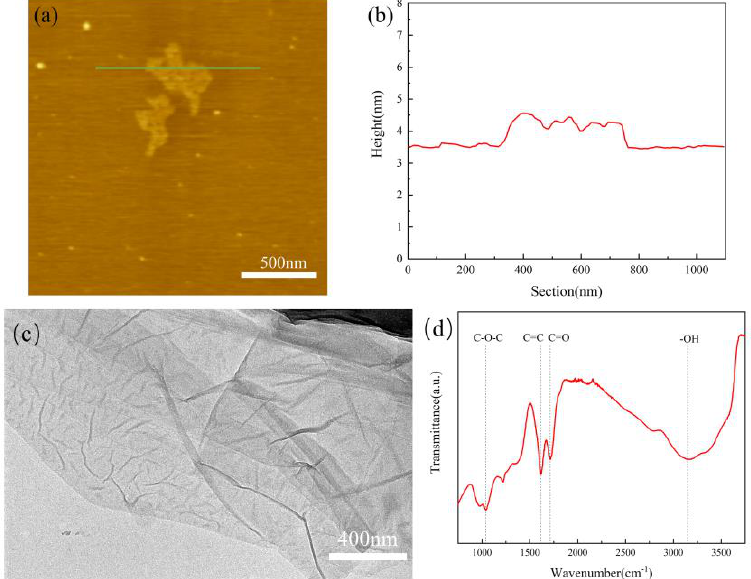
Figure 2. Microstructural characterizations of GO. ( a ) AFM image and ( b ) its height profile, ( c ) TEM image, and ( d ) FTIR spectrum.